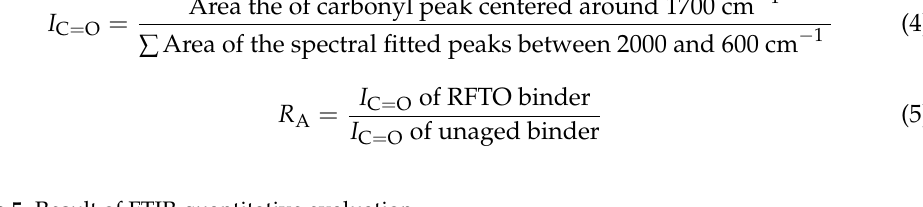
Table 5. Result of FTIR quantitative